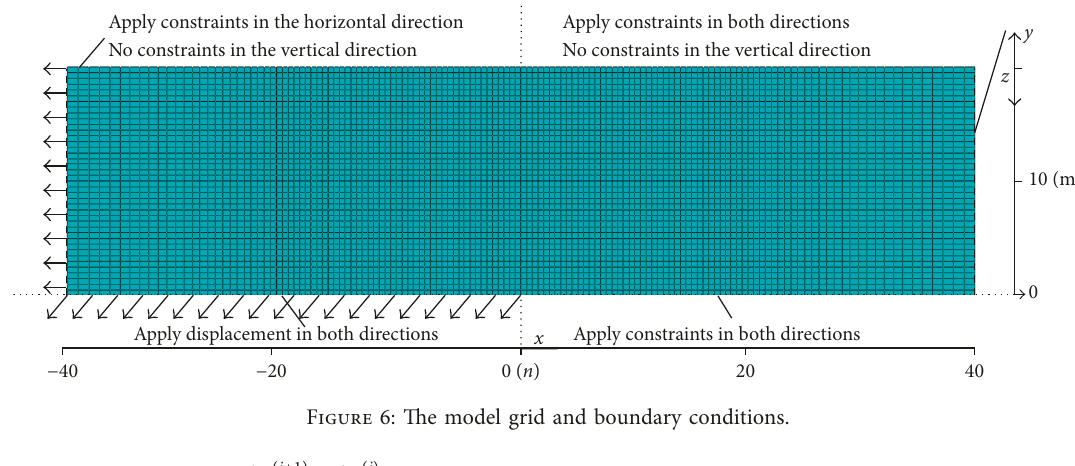
Figure 5: Schematic diagram of the model structure and parameters. L is the width of the obvious deformation zone at the surface, P is the horizontal distance from the maximum inclination point on the ground to the perpendicular bisector of the fault model, S is the horizontal distance from the midpoint of the shear zone to the model’s perpendicular bisector, H is the thickness of the overlying soil, B is the fault dip angle, and d is the vertical displacement of the fault.